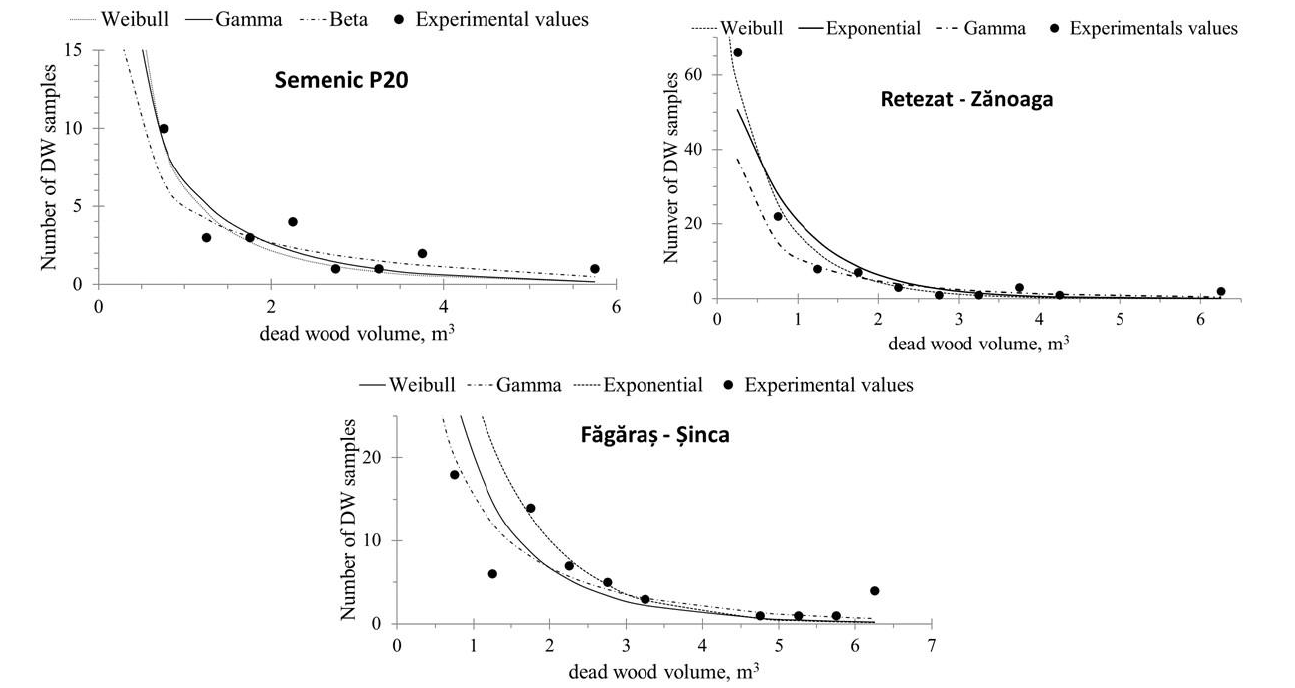
Figure 4. Fitting of experimental DW volume distribution.